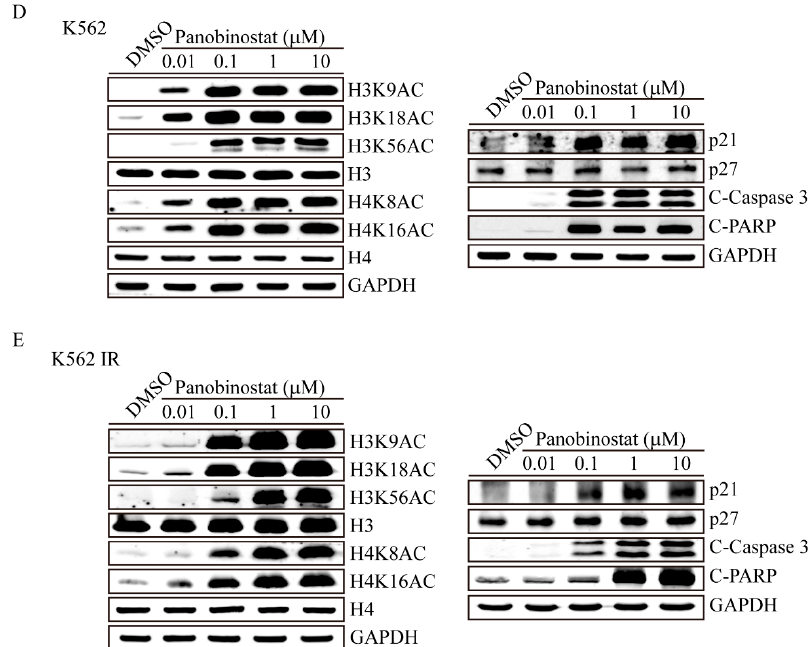
Figure 4. Panobinostat has anticancer effects on imatinib-resistant K562 cells. Both K562 and imatinib-resistant K562 (K562-IR) cells were seeded overnight and treated with 0.001, 0.01, 0.1, 1 and 10 μ M of ( A ) imatinib or ( B ) panobinostat for 24 h. The cells were assessed for cell viability by MTT determination. Data are presented as the mean and standard deviation. Data were analyzed with Student’s t-test; all p -values were two-sided. p -values less than 0.05 are indicated with an asterisk, and values less than 0.01 are presented with two asterisks. ( C ) The IC50 values of imatinib and panobinostat treatments were calculated as the drug concentration that induced a 50% inhibition in cell viability. Immunoblot analyses of histone acetylation (H3K9AC, H3K18AC, H3K56AC, H4K8AC and H4K16AC), cell cycle arrest (p27 and p27) and apoptotic-related protein (C-Caspase 3 and C-PARP) expression following various panobinostat treatments for 6 h and 24 h on both ( D ) K562 and ( E ) K562-IR cells. H3, H4 and GAPDH immunoblots served as internal